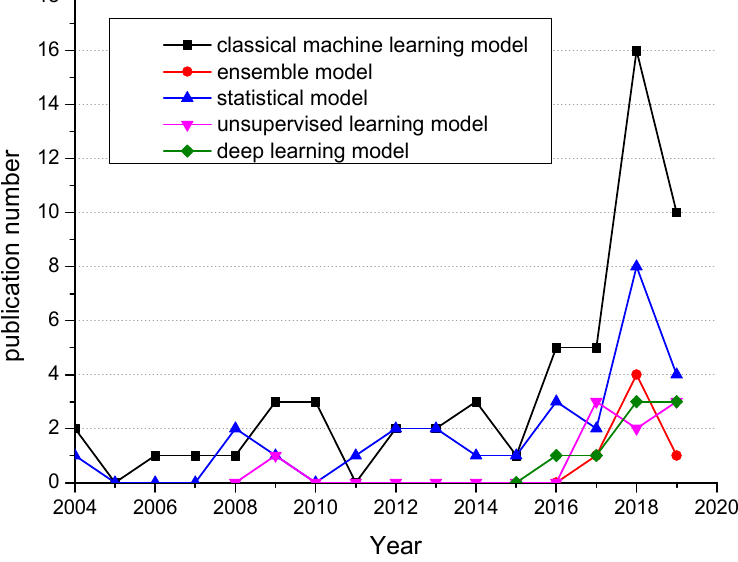
Figure 4. Publication trend for data-driven methods in predictive maintenance of railway track.